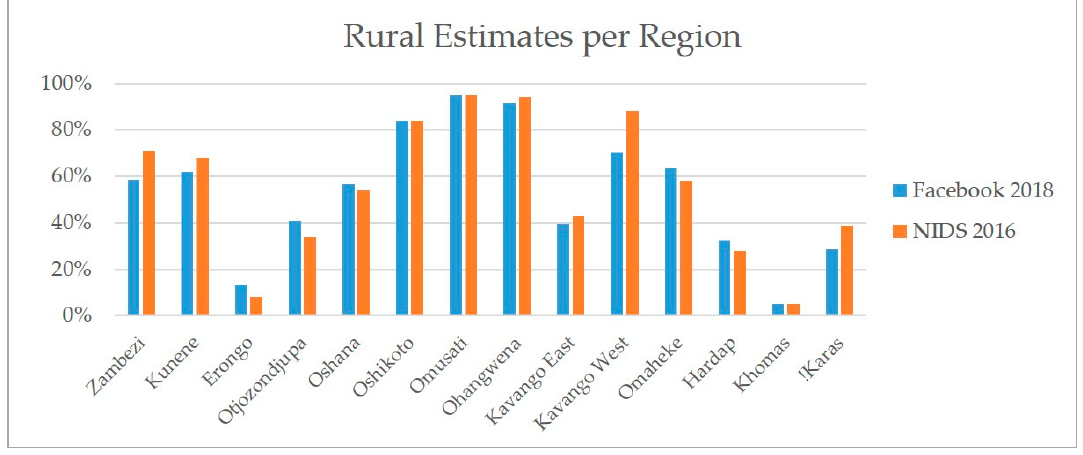
Figure 14. Rural population ratio estimates per region.